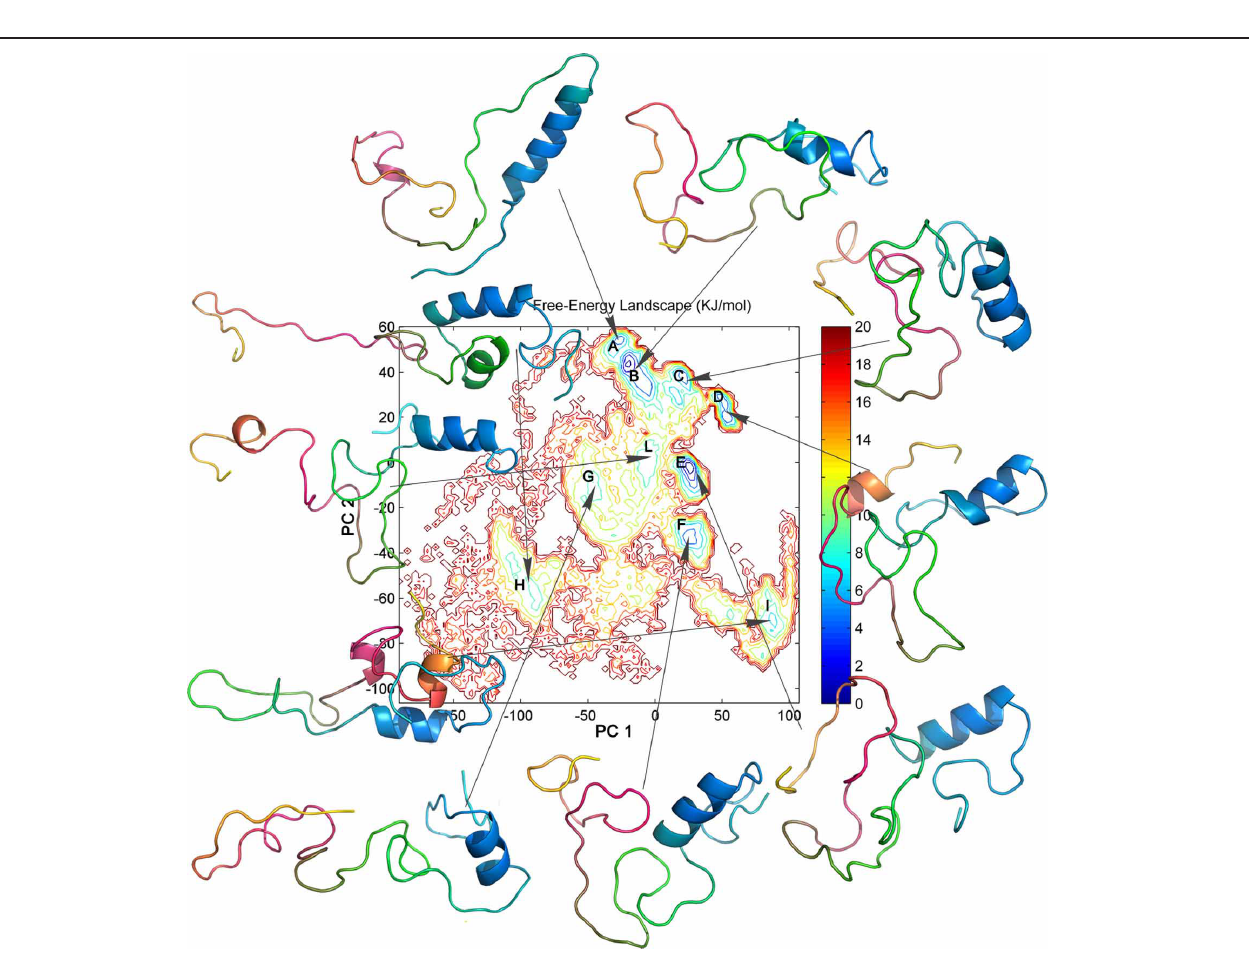
gradient, from blue to red. (B) Cumulative percentage of the variance described by the first ten PCs. The first three (or five) PCs account together for more than 50% (or 70%) of the global motions of the domain.